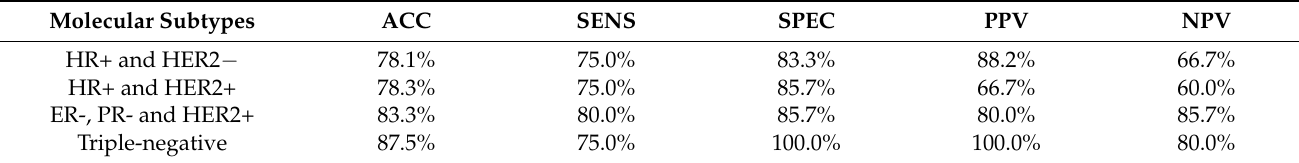
Abbreviations: ER, estrogen receptor; PR, progesterone receptor; HR, hormone receptor; HER2, human epidermal growth factor receptor 2; ACC, accuracy; SENS, sensitivity; SPEC, specificity; PPV, positive predict value; NPV, negative predict